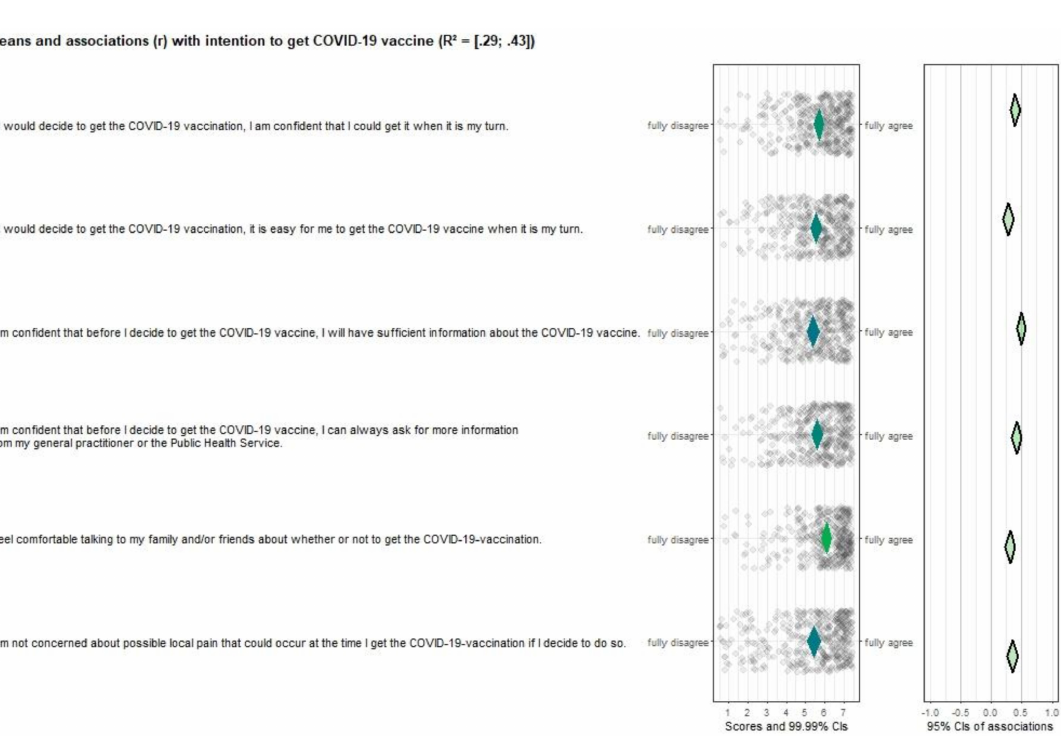
Figure 4. CIBER plot of perceived norm visualizing means and association with intention to get the COVID-19 vaccine.